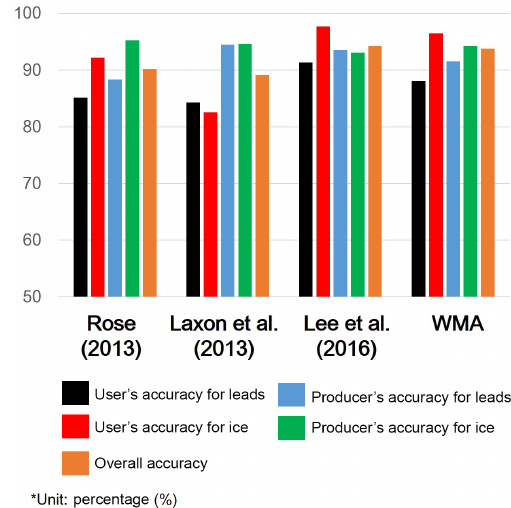
Figure 5. Accuracy assessment results for lead detection with three existing methods and the proposed waveform mixture algo- rithm